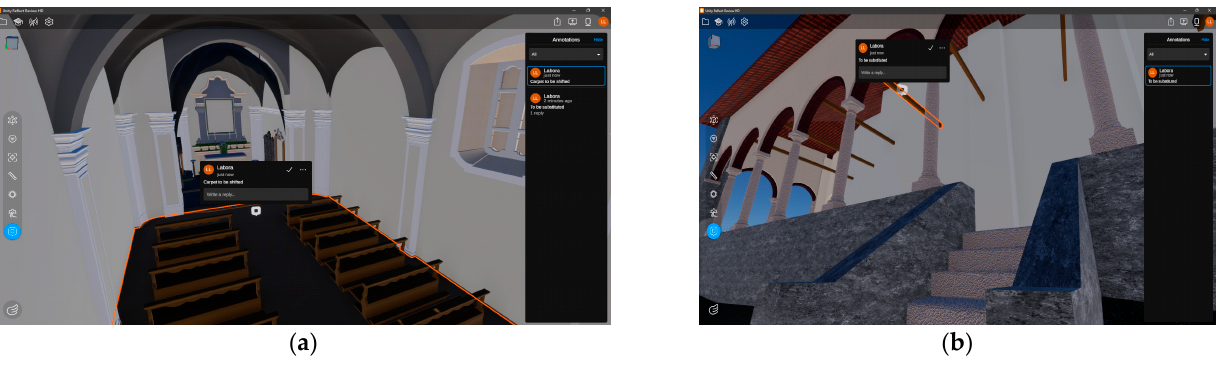
Figure 16. ( a ) Annotation panel open within Unity Reflect; ( b ) another screen with notes.